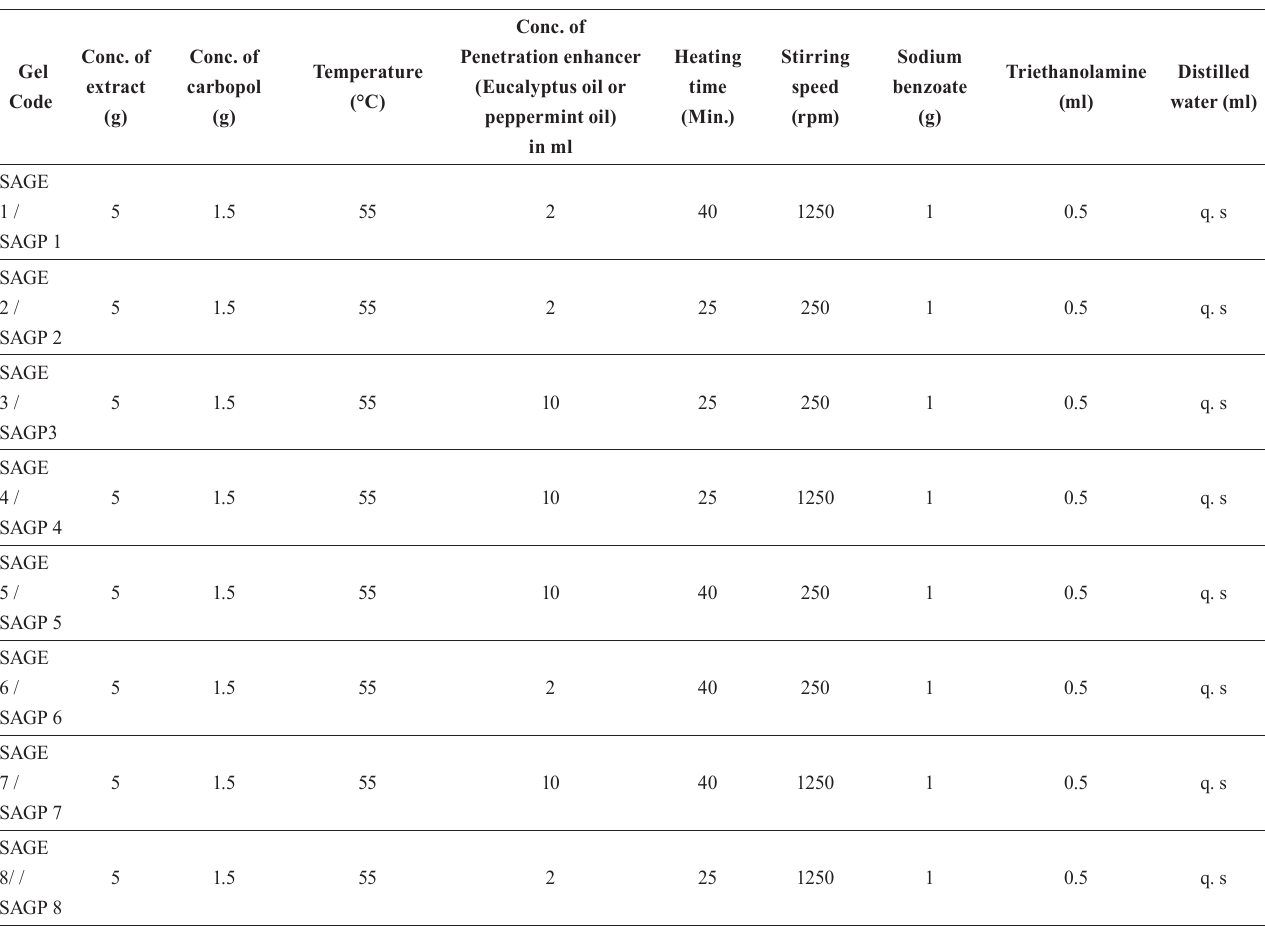
TABLE II - Composition of various batches of SAG with penetration enhancer